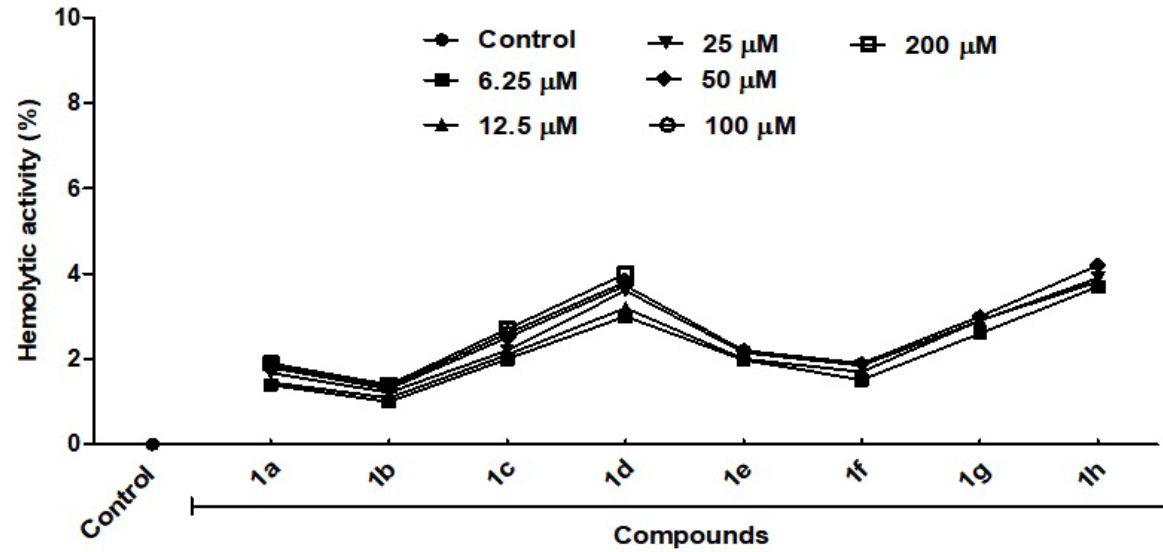
Figure 2. hemolytic activity results in different concentrations promoted by the